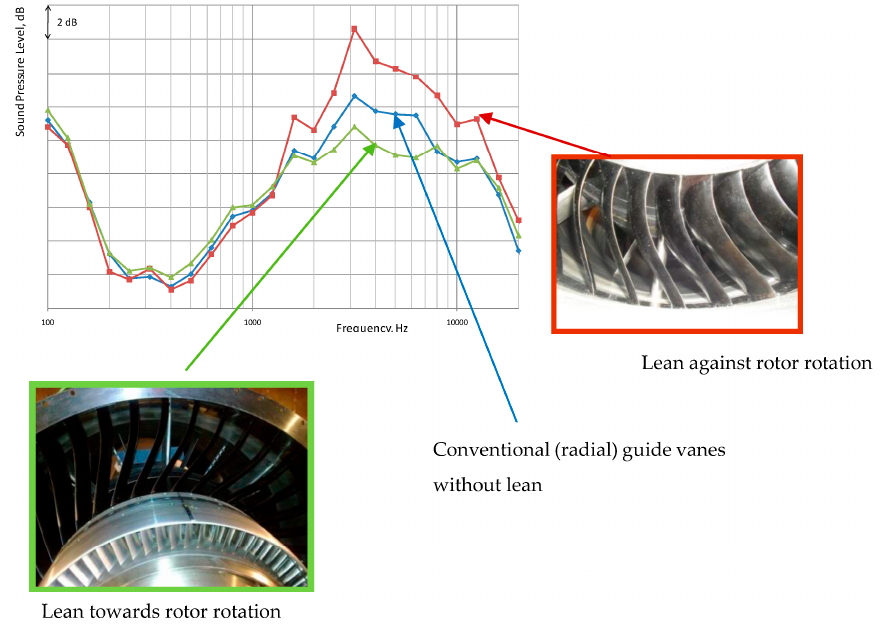
Figure 27. Approach. Rear hemisphere. Blade passing frequency, BPF = 3.15 kHz. 120 ° .